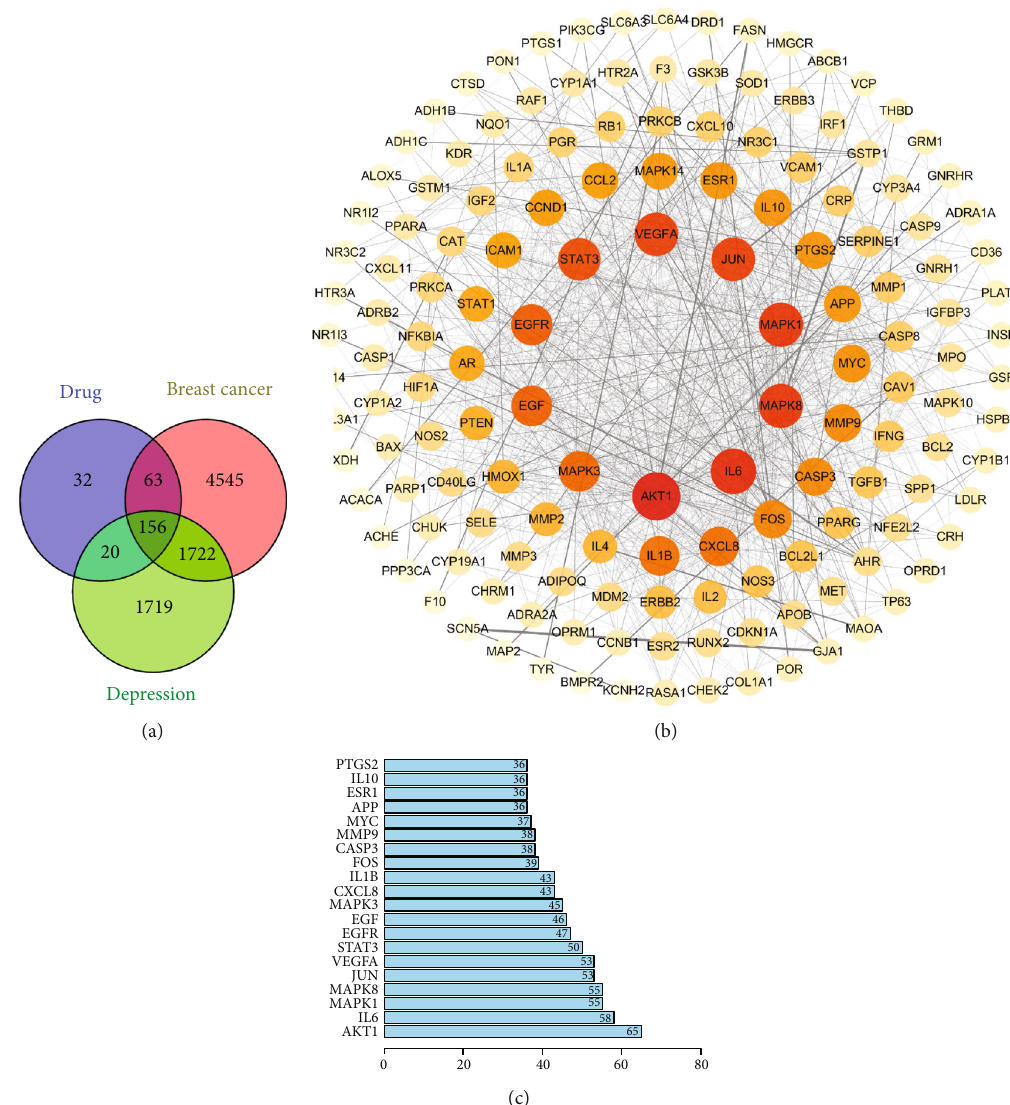
Figure 1: Active targets and PPI network. (a) The overlapped potential active target proteins were presented. (b) The network of PPI containing the active targets was presented. The redder the color, the greater the degree value. The line from thick to thin indicates that the edge betweenness is from big to small. (c) Prediction of the top 20 key targets. The horizontal coordinate is the degree value of each